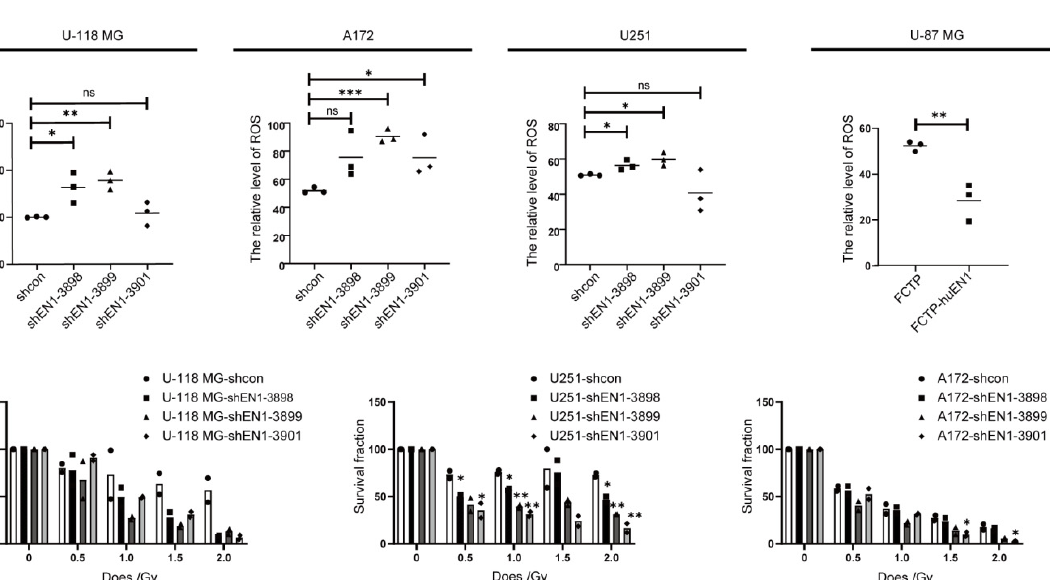
Figure 2. EN1 knockdown restrains the proliferation and migration of glioma cells. ( A ) Assess- ment of knockdown efficiency for EN1 with immunoblotting, and confirmation of EN1 knockout in U251 cells with immunoblotting and genome sequencing. Cell proliferation was assessed using CellTiter-Glo assays ( B ), 5-ethynyl-2’-deoxyuridine (Edu) assays ( C ), and colony formation assays ( D ) ( ● for shcon, ■ for shEN1-3898, ▲ for shEN1-3899, ◆ for shEN1-3901). ( E ) Cell migration was assessed with a wound-healing assay. ( F ) Quantification of wound-healing assay. ( G ) Surviv- al curves for mice bearing xenograft tumors derived from shRNA-EN1 cells or scramble control cells. ( H ) Cell proliferation was assessed by CellTiter-Glo and colony formation assays in U-87 MG cells after EN1 overexpression. Scale bar: 100 μ m. Data are presented as the mean ± SEM from three independent experiments. * p < 0.05, ** p < 0.01, *** p < 0.001, **** p < 0.0001 according to Stu- dent’s t -test. 2.3. EN1 Knockdown Elevated Intracellular ROS Levels and Susceptibility to γ -Ray Irradiation A basal level of reactive oxygen species (ROS) is necessary for cellular proliferation and differentiation [29]; to determine the cellular ROS change after EN1 knockdown, fluorescence sensitive probe H2DCF-DA was used for ROS characterization by flow cy-